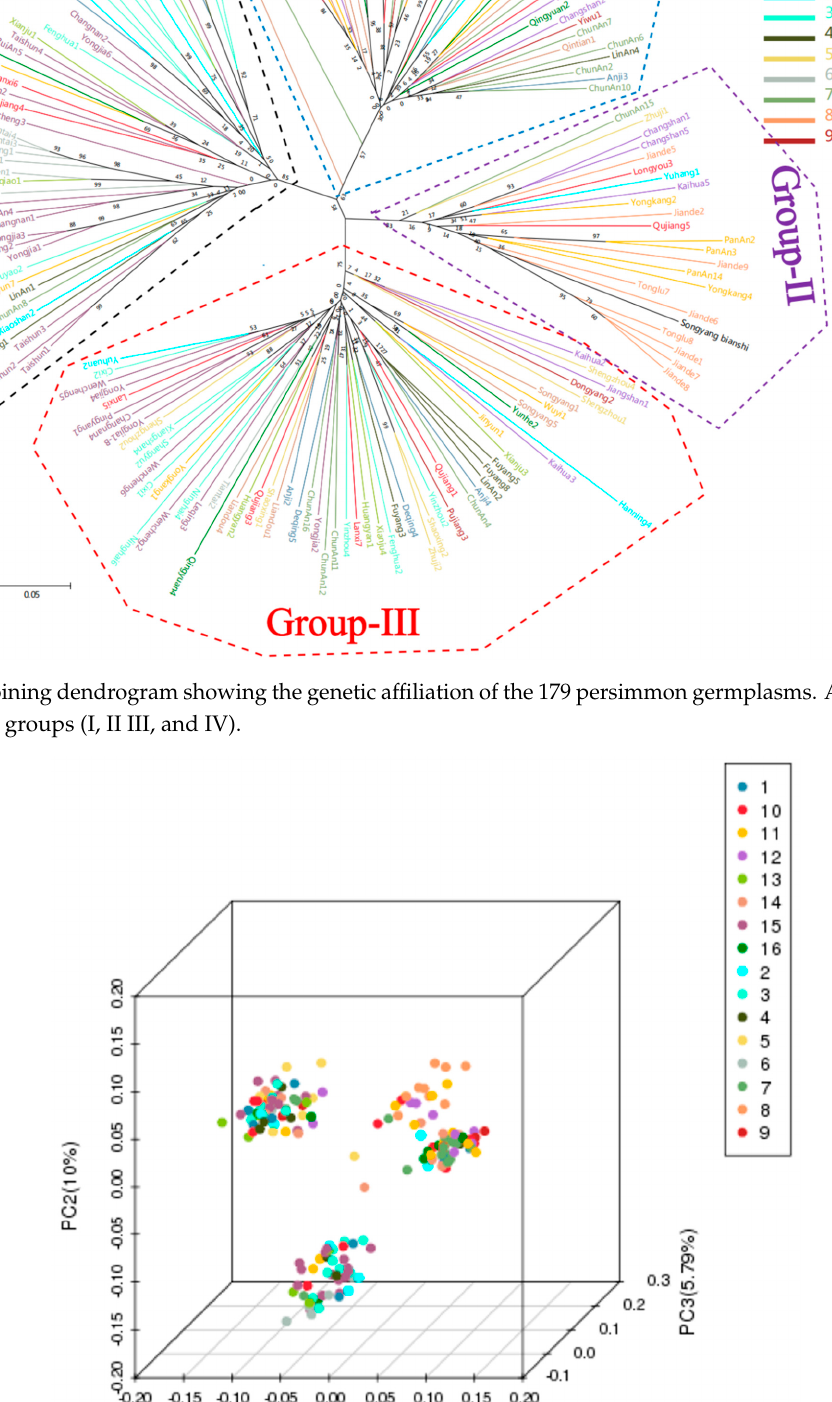
Figure 5. Genetic structure of the 179 persimmon germplasms revealed by principal component analysis (PCA).